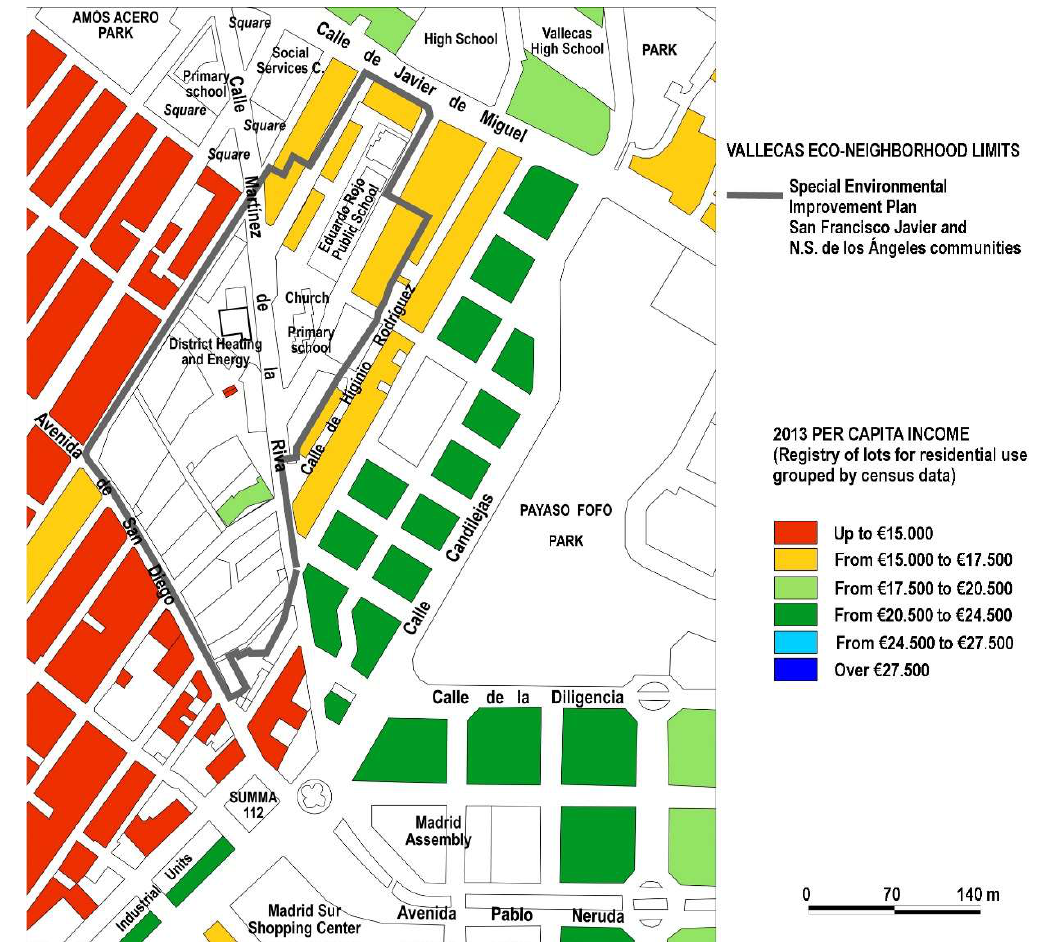
Figure 4. Vallecas eco-neighborhood limits and income levels in surrounding areas. Source: The authors based on Madrid City Council data, 2017 [51].